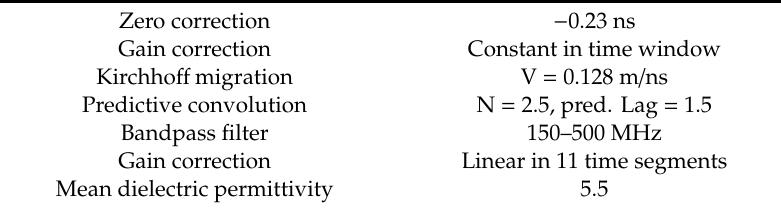
Table 2. Most relevant flow processing steps.